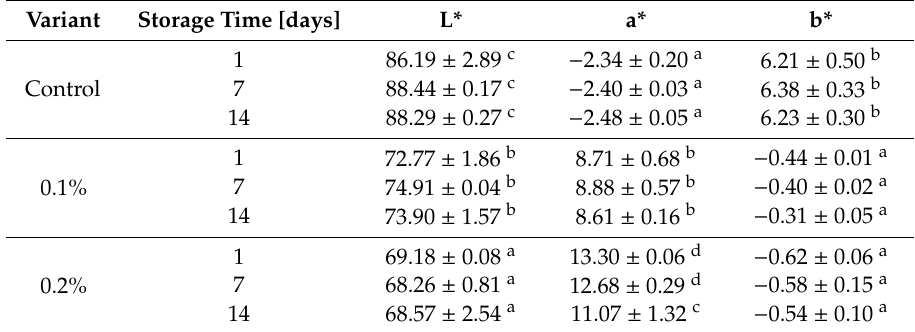
Table 3. Color parameter (L*, a*, b*; L*: lightness; 100 = white, 0 = black, a*: redness; ± , red; green and b*: yellowness; ± , yellow; blue) changes in yoghurt during